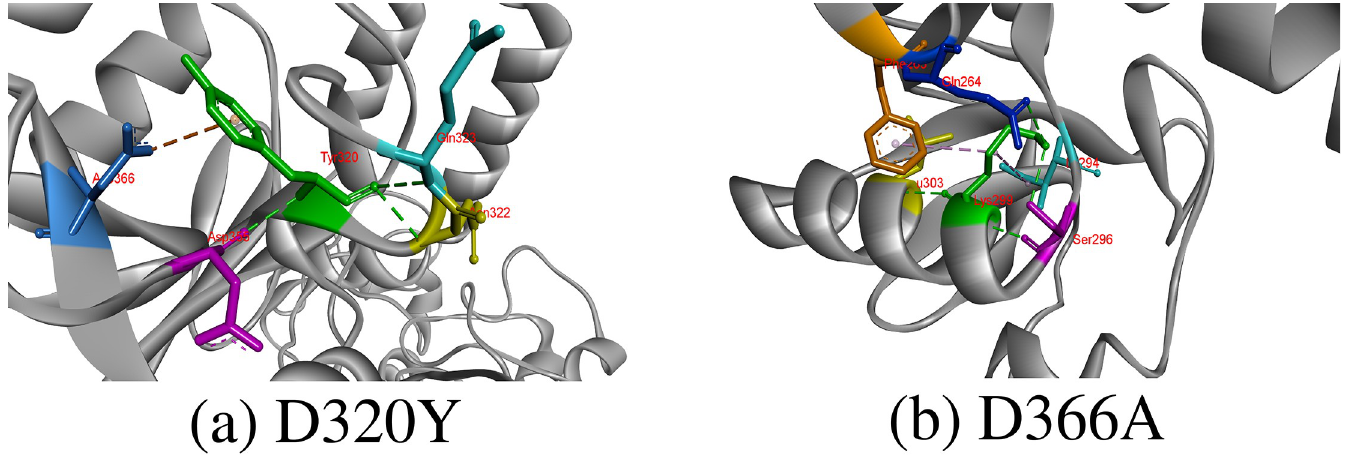
Fig 4. Hydrogen bonds and other interaction created by substituted amino acid at 320 and 366 positions in CD-209. The substituted amino acids are represented in green color, which form interaction with other surrounding residues colored differently. Moreover, green color is also selected to indicate hydrogen bond, whereas other bond colors represents other hydrophobic or electrostatic interactions.